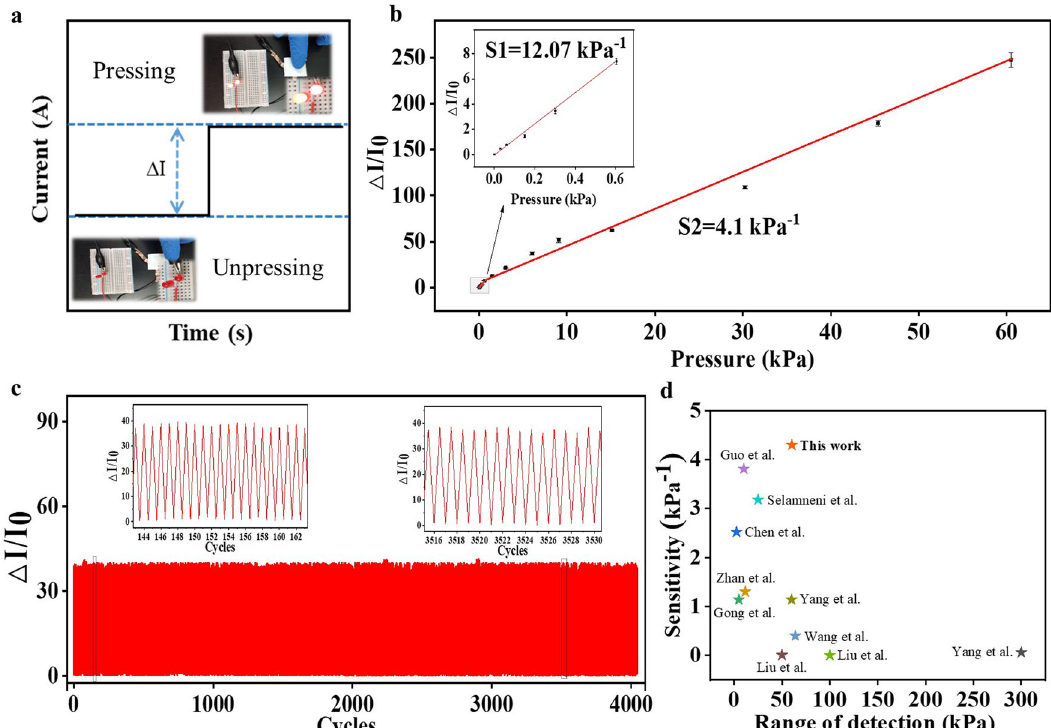
Fig. 2 Electrical performance of the fully paper-based fl exible piezoresistive sensor. a The currents generated when pressure loaded on the sensor, disappeared when unloaded. b The fractional change of current from a fully paper-based fl exible piezoresistive sensor under pressing, the enlarged view in a small pressure range of 0 – 0.6 kPa. c The fractional change of current in the 4000 cycles, the enlarged diagrams for 144 – 162 cycles and 3517 – 3530 cycles. d Comparison of this work with currently reported paper-based pressure sensors in terms of sensitivity and range of